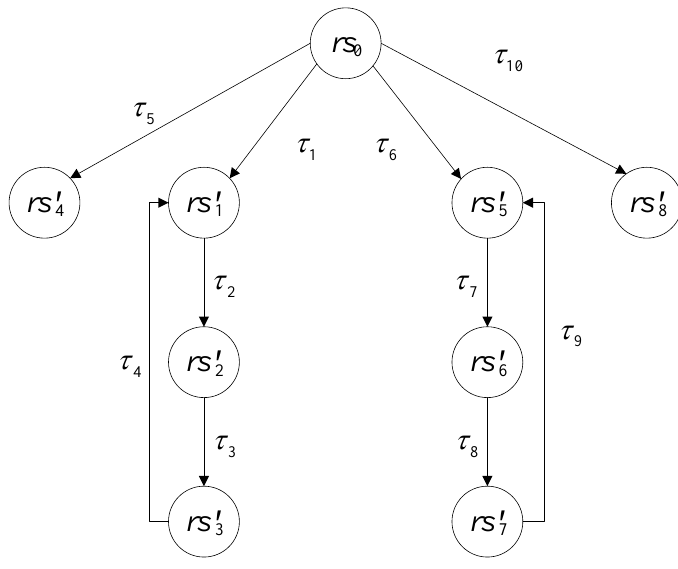
Figure 7. Automaton of feed-water control